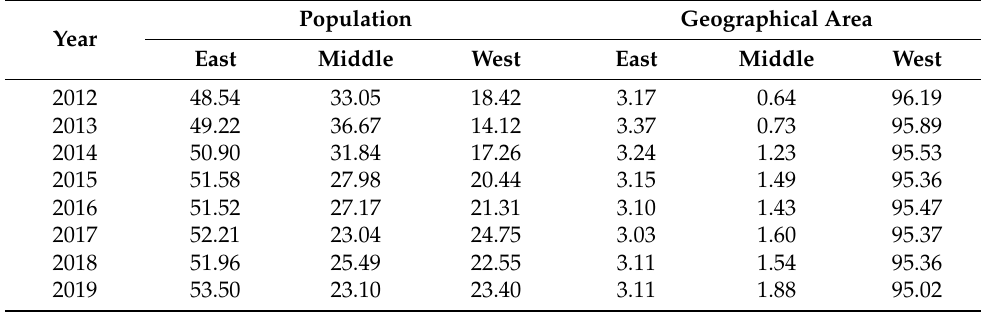
Table 8. Proportion of differences in contribution in the intra-east, middle, and west regions